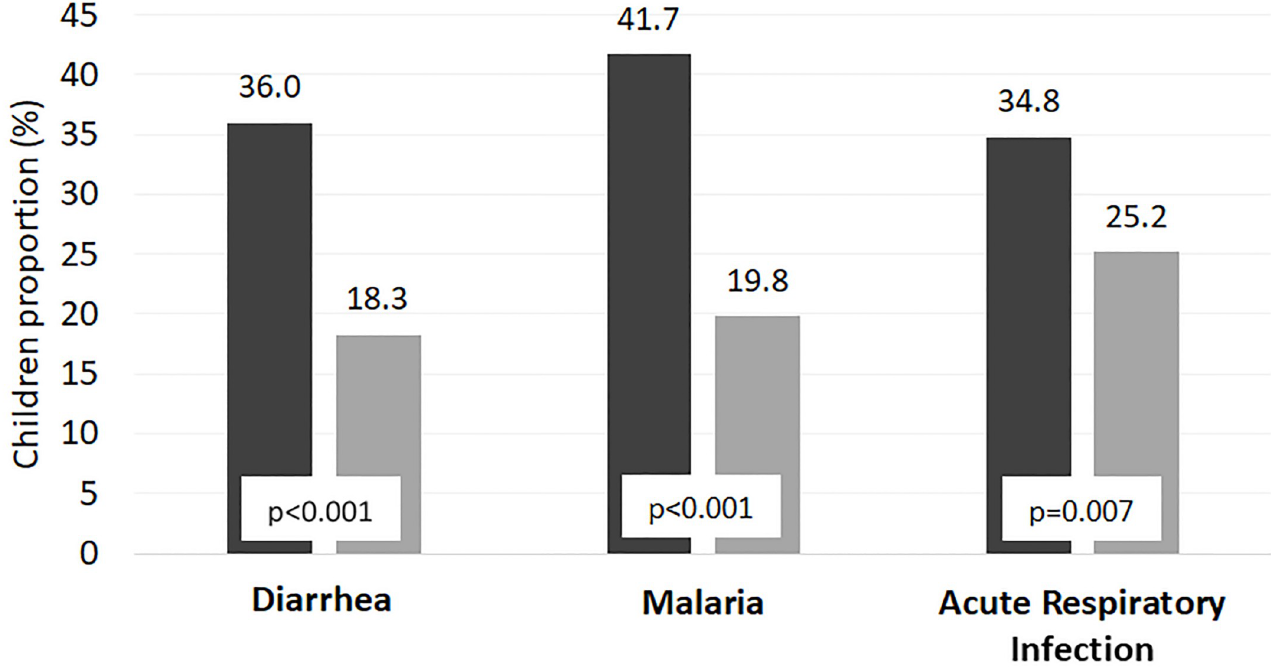
Fig 3. Proportion of other diseases detected during outpatient treatment of severe acute malnutrition compared between the two models.